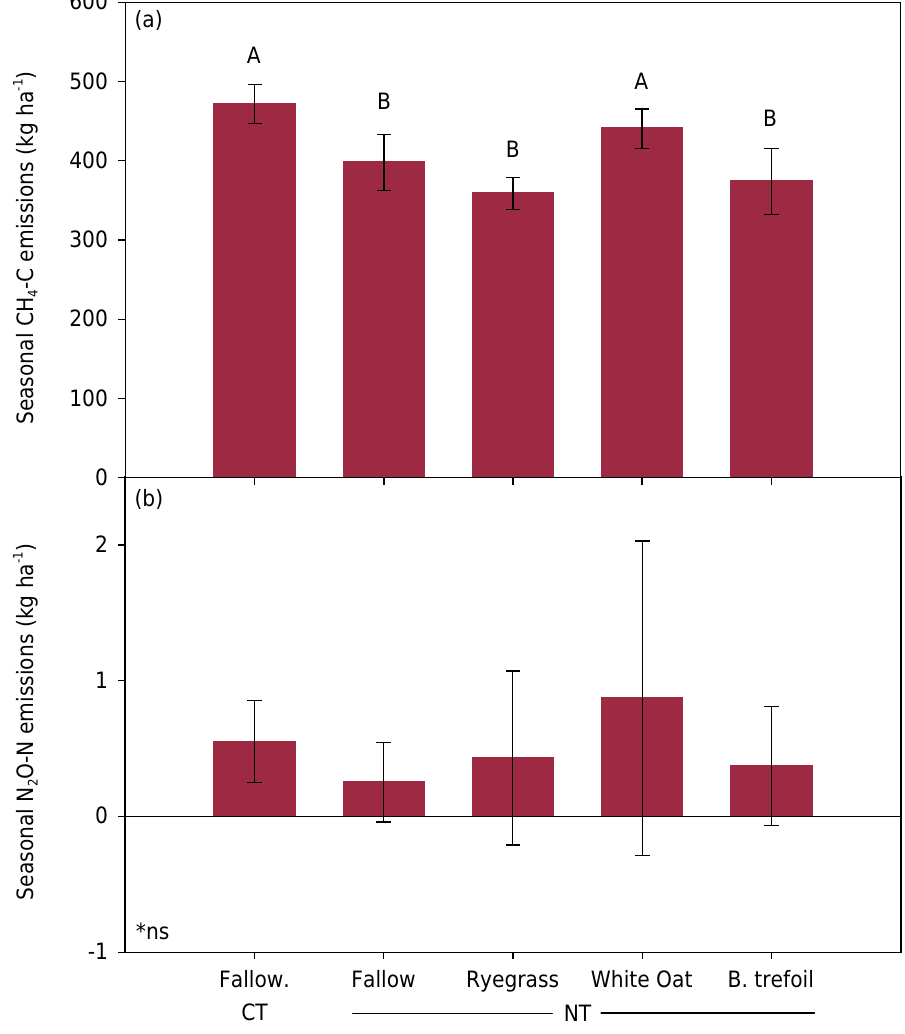
Figure 1. Seasonal emissions of (a) methane (CH 4 ) and (b) nitrous oxide (N 2 O) in a subtropical Gleysol subjected to different soil winter management (fallow or cover crops) combined with conventional tillage (CT) or no-tillage (NT) in Southern Brazil. Vertical lines denote the mean standard deviation. Different letters on the bars indicate a significant difference between treatments by the Test of Skott-Knott at 5 % level. ns: no significant.